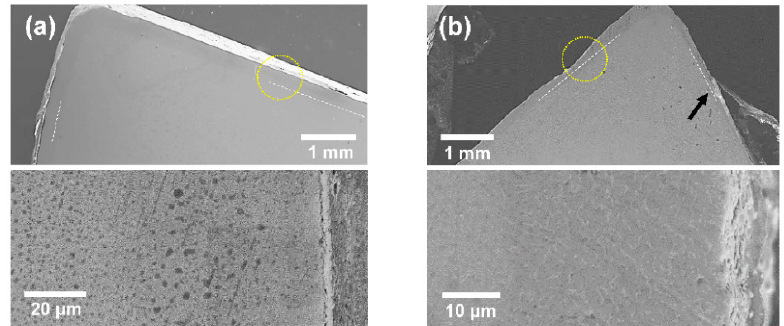
Figure 5. SEM micrographs of the ( a ) HT-1 and ( b ) HT-3 samples after heat treatment in a 4% H 2 -Ar atmosphere.